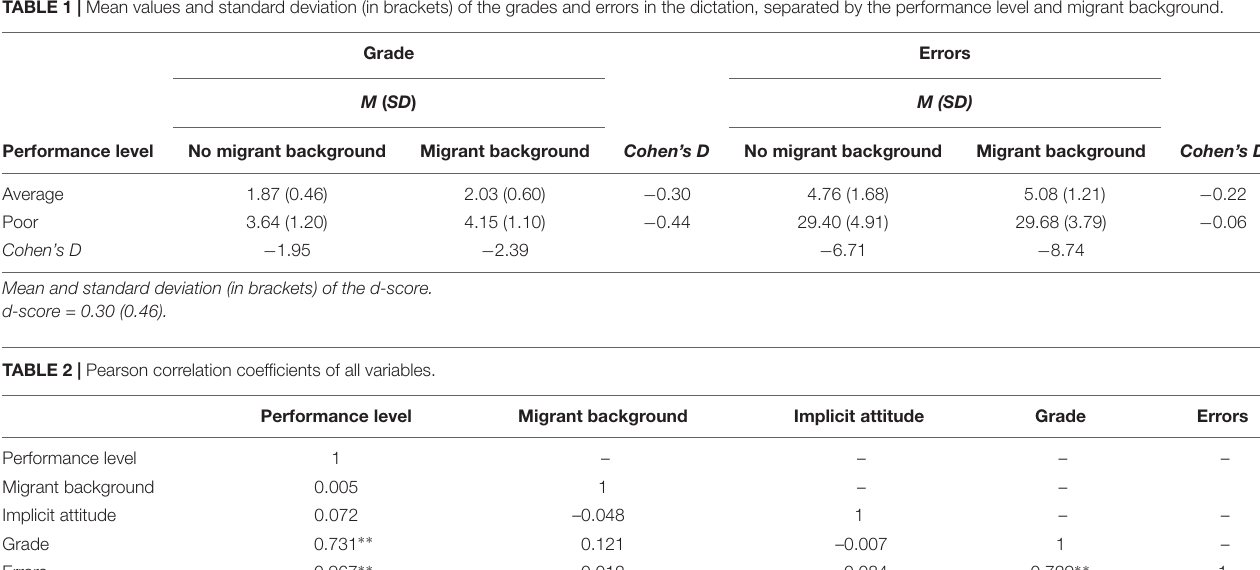
TABLE 1 | Mean values and standard deviation (in brackets) of the grades and errors in the dictation, separated by the performance level and migrant background.